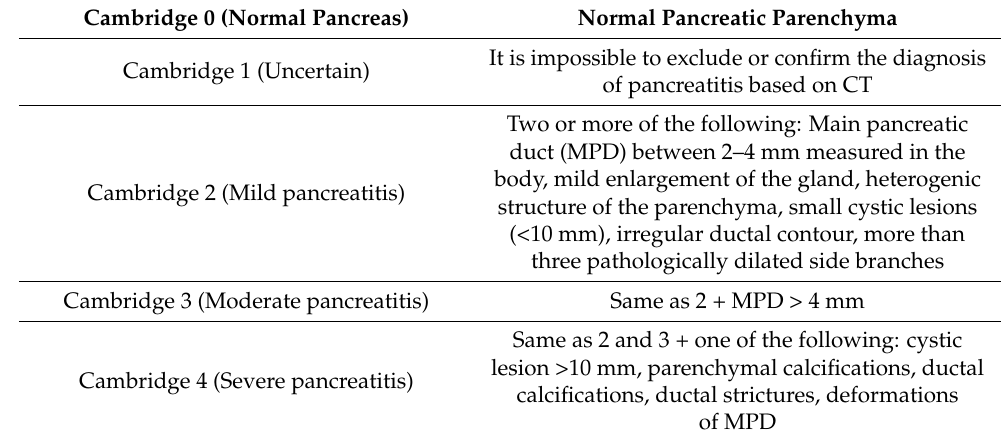
Table 2. Cambridge classification of CP adapted for